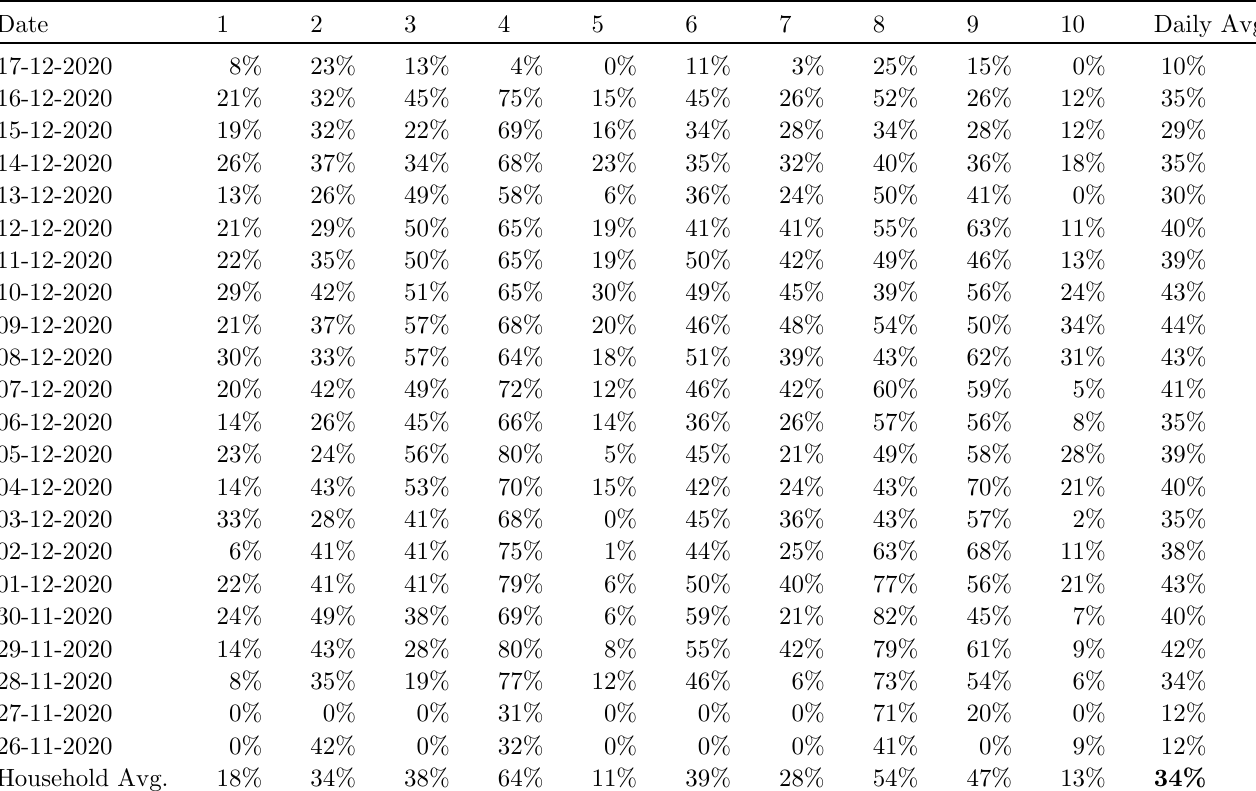
Table 4. Percentage of Surplus Power available for ten different SHS from 25th Nov to 17th